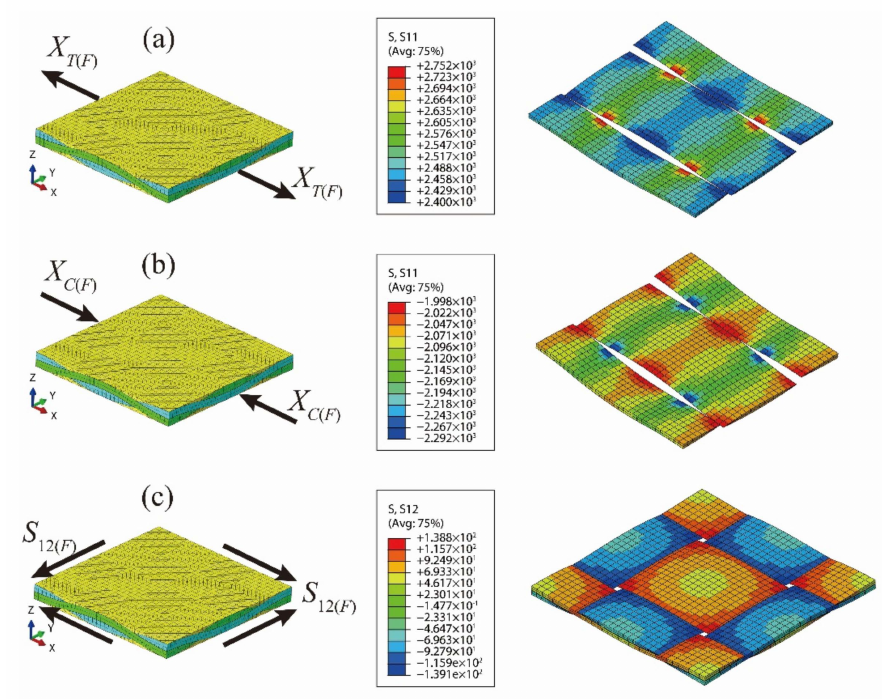
Figure 10. Numerical stresses of the fiber tows calculated with the meso-scale RUC under the macro- scale strengths of the fabric laminates: ( a ) numerical result of RUC under X T(F) ; ( b ) numerical result of RUC under X C(F) ; ( c ) numerical result of RUC under S 12 (F)